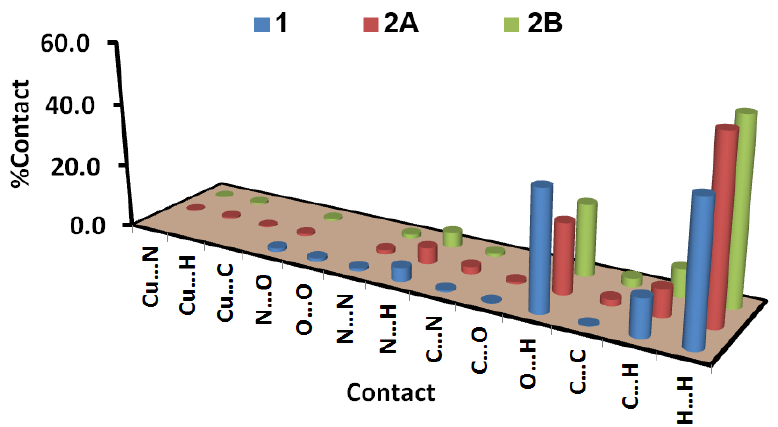
Figure 8. The intermolecular interactions in complexes 1 and 2 .